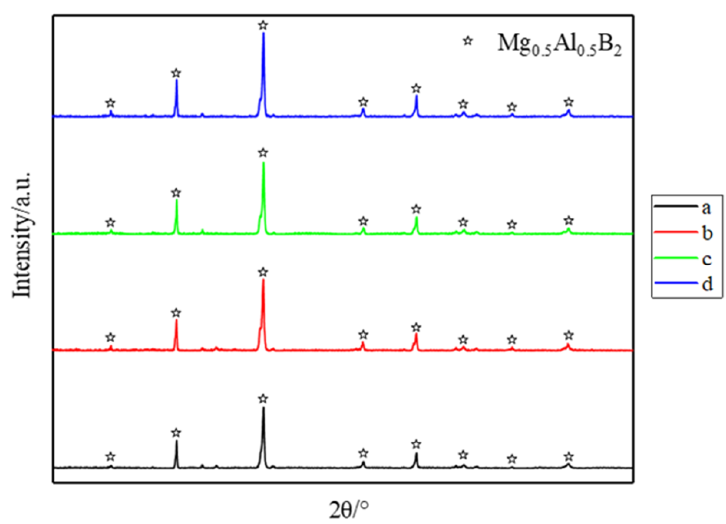
Figure 4. XRD patterns of samples sintered at 1000 °C for different holding times: ( a ) 0.5 h, ( b ) 1 h, ( c ) 1.5 h and ( d ) 2 h.